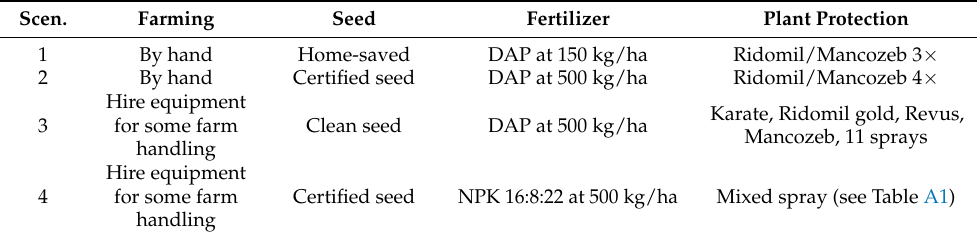
Table 2. Overview of Scenarios.